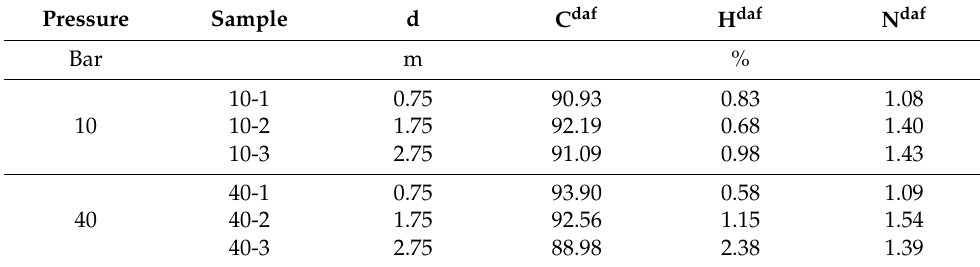
Table 2. The results of elemental analysis of residues after coal